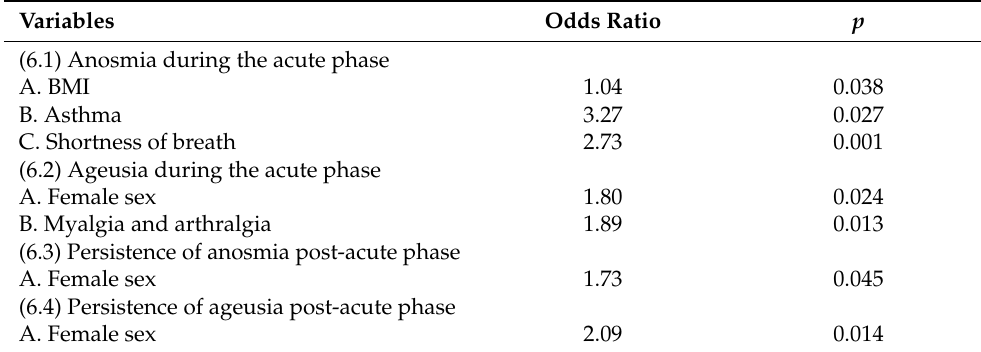
Table 6. Factors associated with anosmia and ageusia in multivariable